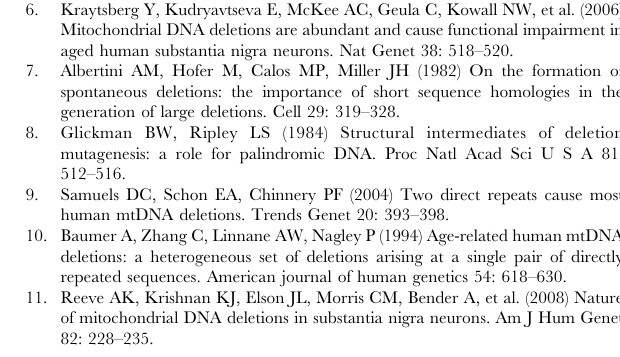
Figure S2 Frequency difference distribution of direct repeats (DR). Frequency difference distribution of DR between random R1 sequences from human and from rat (100 R1 from each or 10,000 total differences) for DR sizes from 6 to 13 bp. The frequency difference between the native human and rat mtDNA ( ||| ) is also shown with the p-value (2-sided, z-test) noted in each subfigure. Figure S3 Frequency difference distribution of direct repeats (DR). Frequency difference distribution of DR between random R1 sequences from rhesus monkey and from rat (100 R1 from each or 10,000 total differences) for DR sizes from 6 to 15 bp. The frequency difference between the native rhesus monkey and rat mtDNA ( ||| ) is also shown with the p-value (2-sided, z-test) noted in each subfigure. Figure S4 Frequency difference distribution of direct repeats (DR). Frequency difference distribution of DR between random R1 sequences from mouse and from rat (100 R1 from each or 10,000 total differences) for DR sizes from 6 to 15 bp. The frequency difference between the native mouse and rat mtDNA ( ||| ) is also shown with the p-value (2-sided, z-test) noted in each subfigure. Figure S5 The distributions of left and right DR sequences ( $ 6 bp). The distributions of left and right DR in the mtDNA minor and major arcs and the mean distributions of R1 random sequences in (a) human, (b) rhesus monkey, (c) mouse and (d) rat.